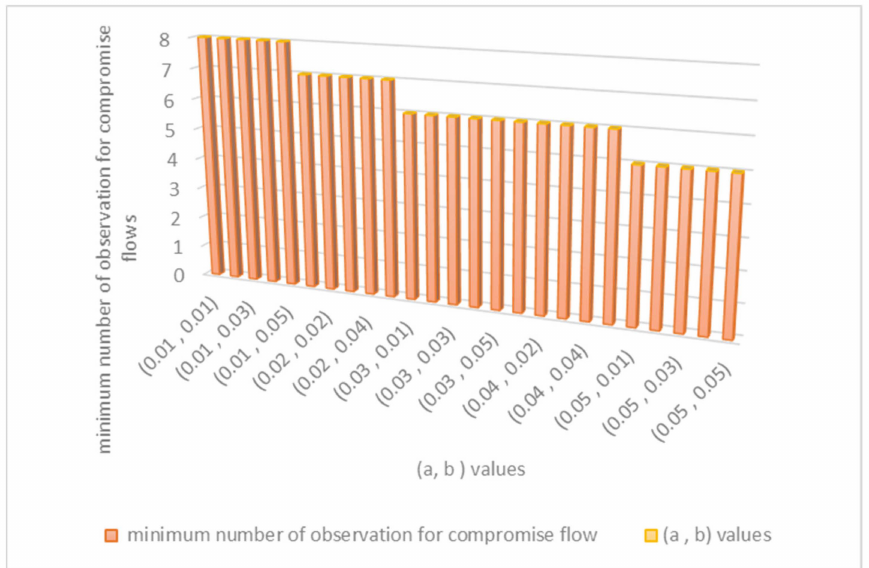
Figure 3. Method of finding the best values for (a) and (b)